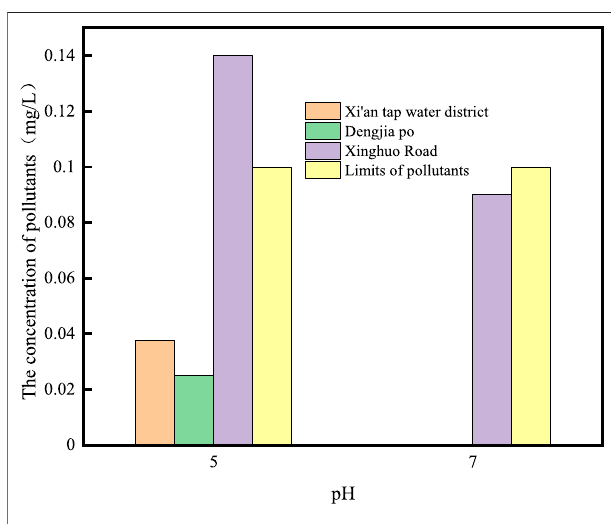
FIGURE 11 | Enhanced leaching test results of Cr from recycled